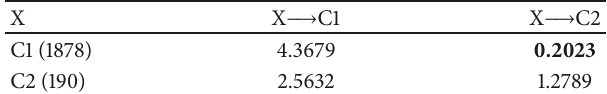
Table 6: The number of nodes in each cluster and the ratio of the numberofedgesbetweenclustersorinsidetheclustertothenumber of nodes in the cluster in Gnutella network (Fiedler method). X X 󳨀→